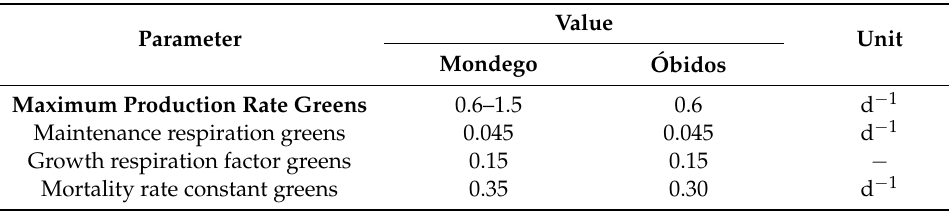
Table 2. Parameters used in WAQ